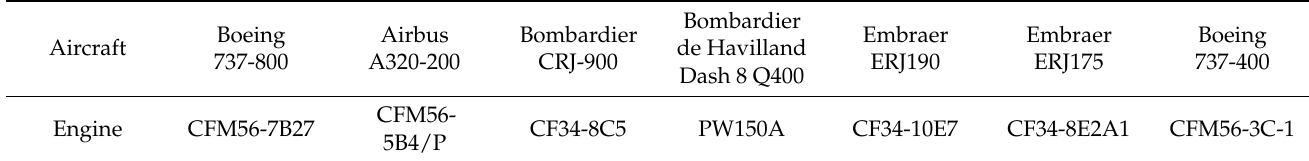
Table 2. Summary of engines assigned to individual